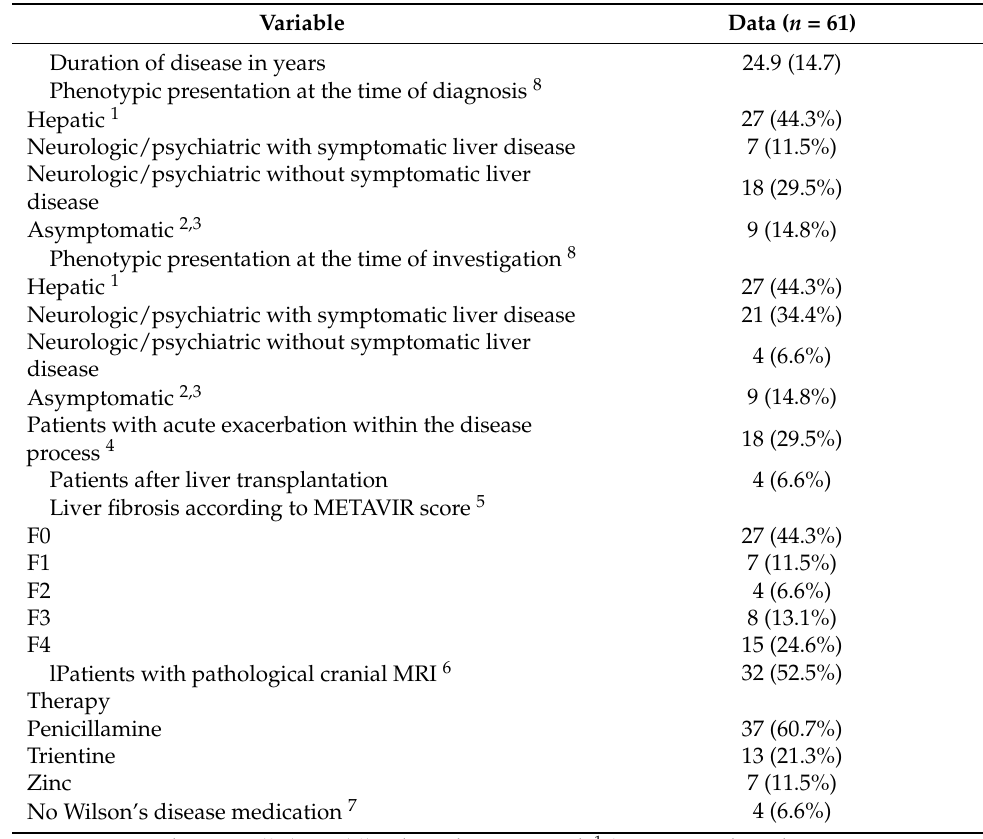
Table 2. Clinical characteristics of WD